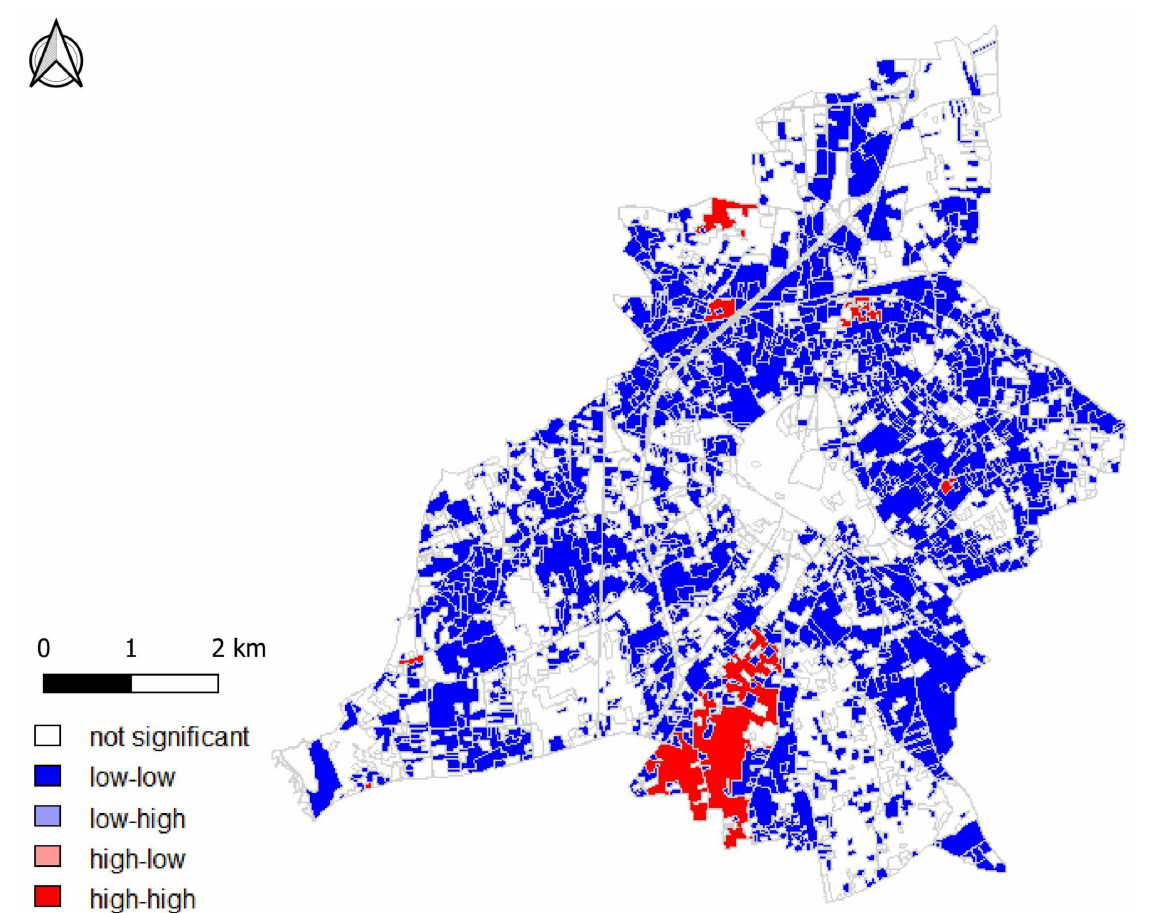
Figure 6. LISA cluster maps ( p = 0.01). H-H cluster indicates that a spatial unit with high NCF is surrounded by high-land consumption units; H-L cluster indicates a spatial unit with a high NCF that is surrounded by low-land consumption neighbors; L-H cluster indicates a spatial unit with a low NCF that is surrounded by neighboring units that have a high land consumption; and L-L cluster indicates a spatial unit with a low NCF that is surrounded by low-land consumption spatial